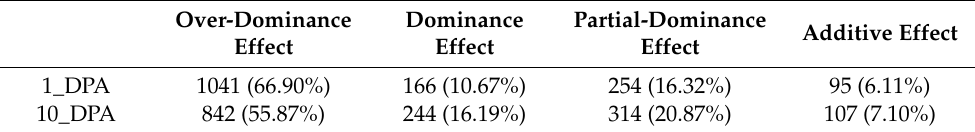
Table 2. The mode of inheritance for